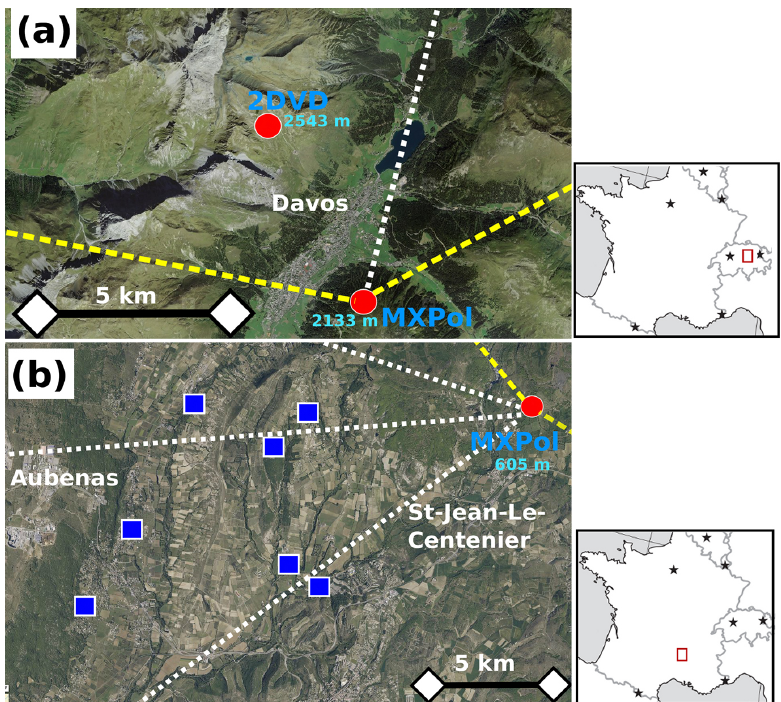
Figure 1. Maps of the two field deployments of MXPol considered in this study. (a) Deployment in Davos (CH); (b) deployment in Ardèche (FR) . The yellow lines indicates the extent of the PPI sector scans, while the white lines indicates the directions of the RHI scans. Red circles are used to mark the locations of instruments directly employed in the study (MXPol and a 2DVD two-dimensional video disdrometer), while blue squares are used for laser disdrometers (Parsivel) employed only to parametrize the attenuation correction of Z H and Z DR . The source of the aerial view of (a) is http://www.geo.admin.ch, and that of (b) is